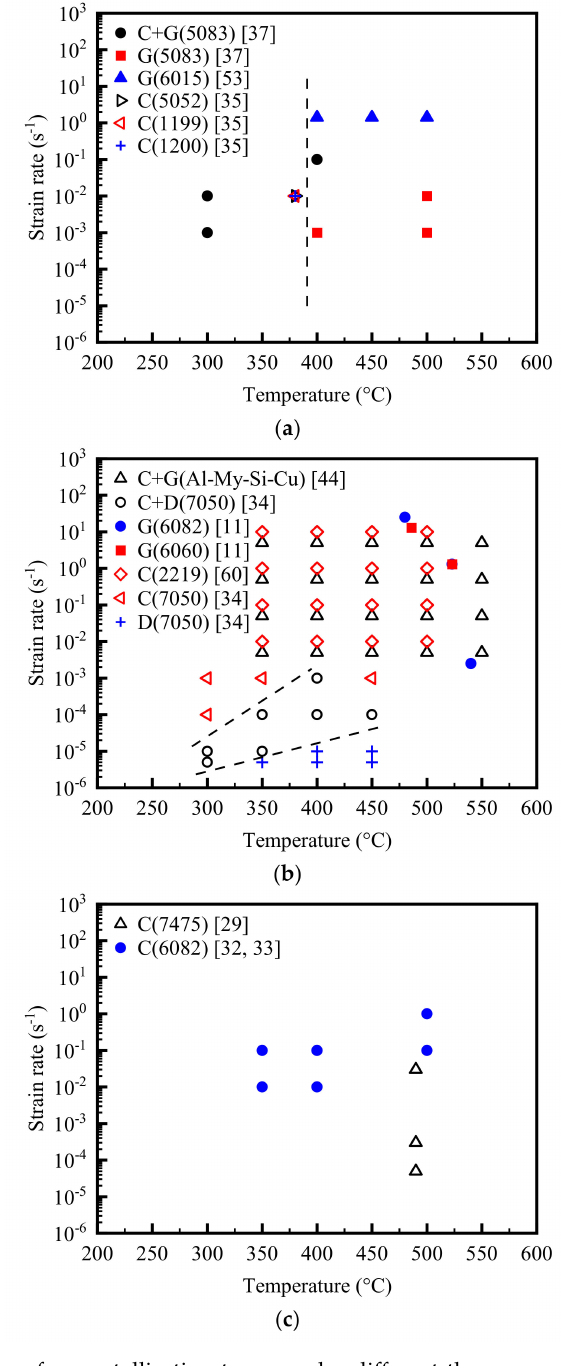
Figure 4. A summary of recrystallisation types under di ff erent thermomechanical conditions for ( a ) as-fabricated [35,37,53], ( b ) quenched and naturally aged [11,34,44,60], ( c ) as-homogenised 7xxx and T6-6xxx alloys [29,32,33]. Note: solid symbols represent torsion tests, while hollow and cross symbols represent compression tests. C, D and G represent CDRX, DDRX and GDRX